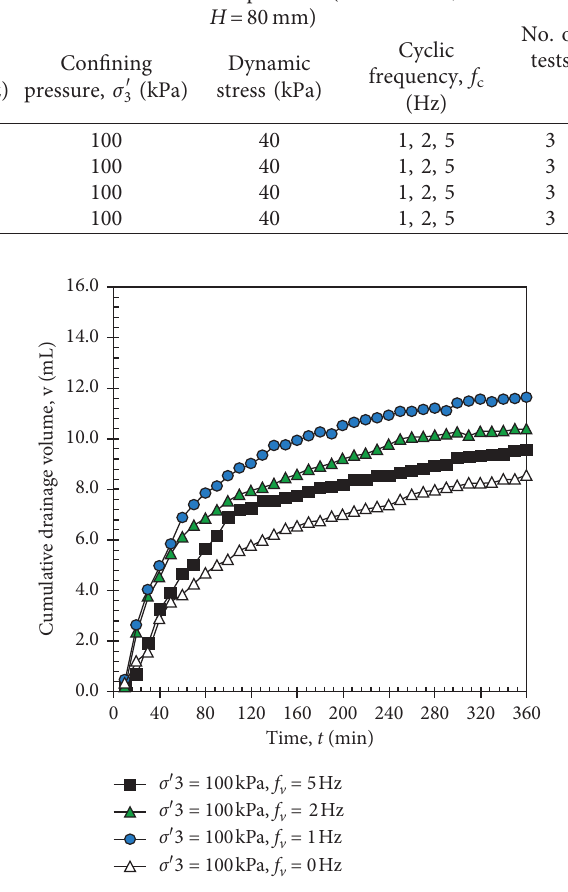
Figure 3: Variation of cumulative drainage volume with time.